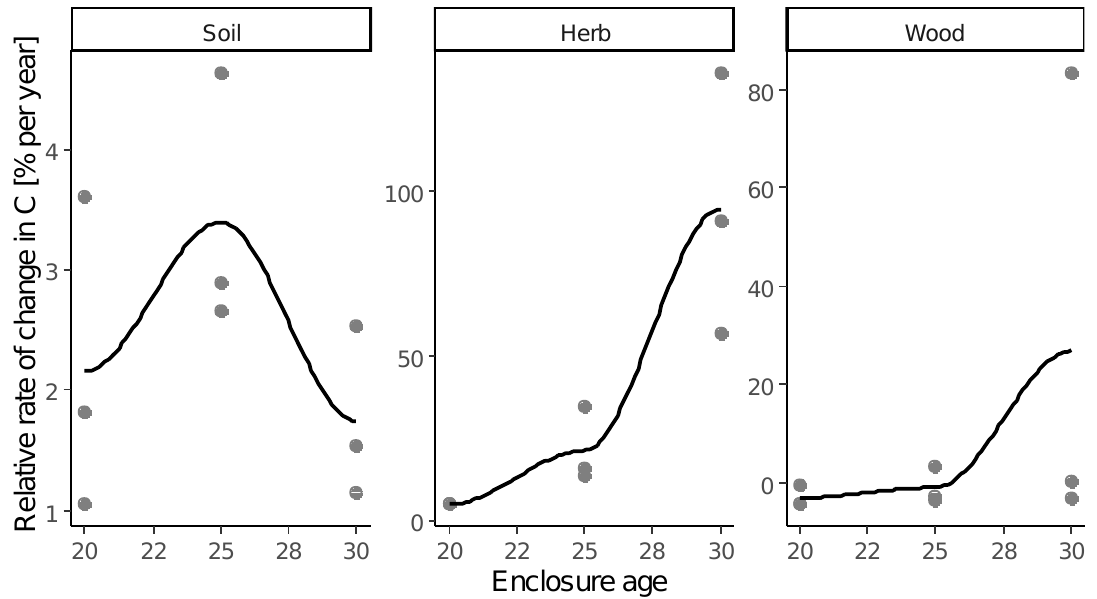
Figure 3. Trends in the relative rate of change in soil, herbs, and woody carbon stocks with increasing enclosure age.